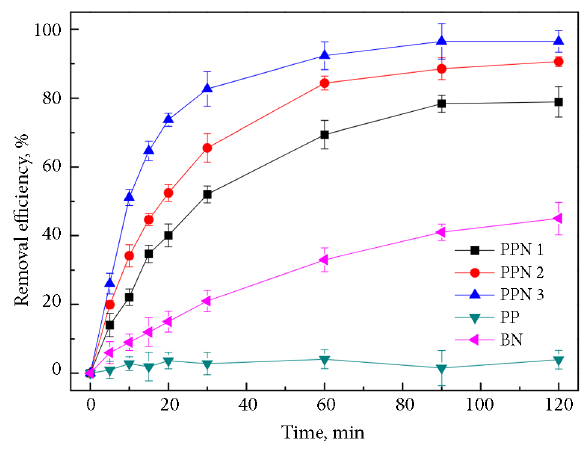
Figure 4. Removal of Cr(VI) by PP, PPN, and BN. The Fe 0 loadings of PPN1, PPN2, and PPN3 are 3.22, 4.85 and 6.36 mg, respectively, and the dosage of BN is 7 mg